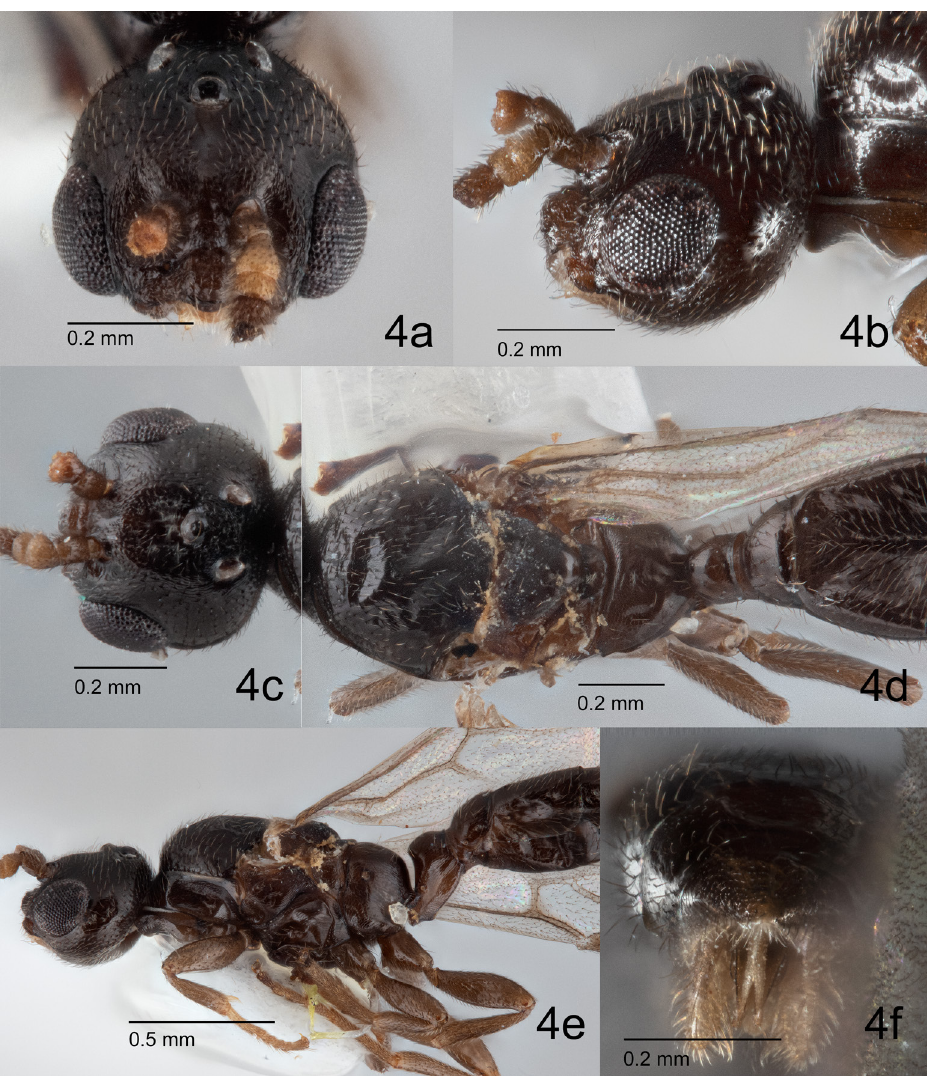
Fig. 4. Rhopalomastix impithuksai Wang & Jaitrong sp. nov., paratype, ♂ (ZRC_ENT00007608). a . Head in full face view. b . Head in lateral view. c . Head in dorsal view. d . Mesosoma and waist in dorsal view. e . Body in lateral view. f . Genitalia in posterior